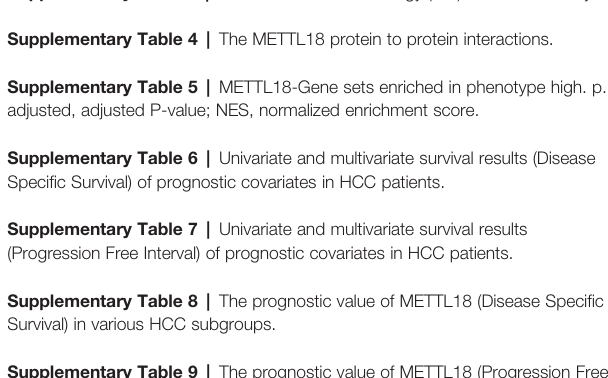
Supplementary Table 2 | METTL18-related differential expressed Genes. Supplementary Table 3 | METTL18 of Gene ontology (GO) enrichment analysis. Supplementary Table 4 | The METTL18 protein to protein